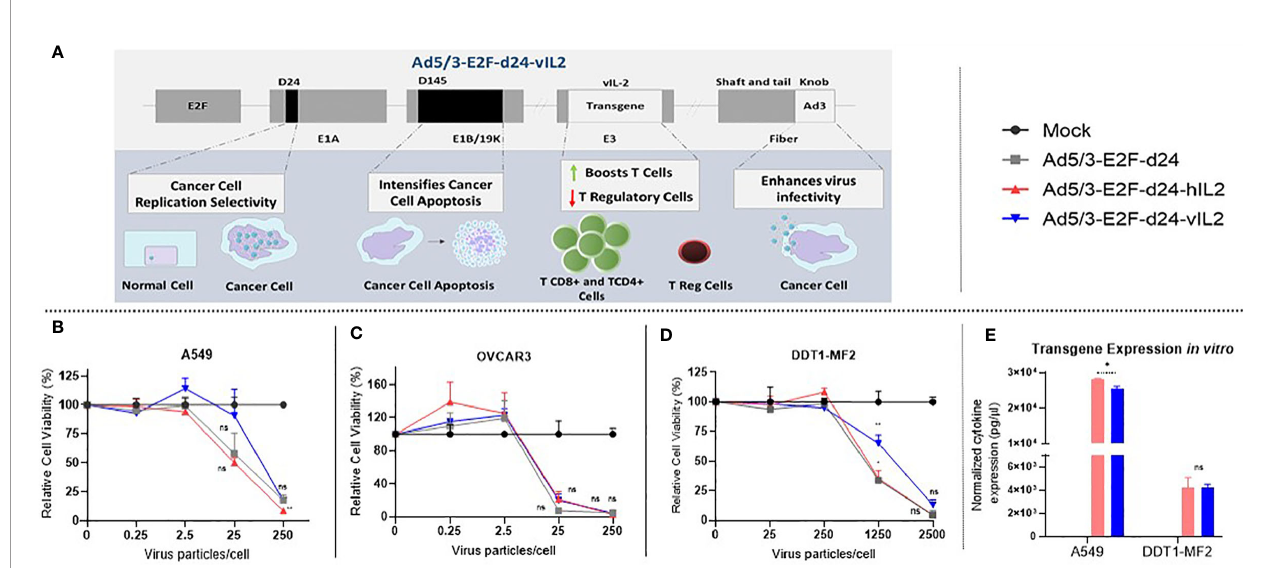
FIGURE 1 | View on the Ad5/3-E2F-d24-vIL2 virus construct and functionality testing in vitro . (A) Graphical illustration of the features of the virus genome. (B – D) Relative cancer cell viability upon Ad5/3-E2F-d24-vIL2 virus infection for 3 (A549) or 5 days (OVCAR3 and DDT1-MF2). (B) Human lung cancer cell line (A549). (C) Human ovarian cancer cell line (OVCAR3). (D) Hamster leiomyosarcoma cancer cell line (DDT1-MF2). (E) Normalized transgene production in supernatants of virus-infected A549 and DDT1-MF2 cancer cells at 250 and 2500 vp, respectively. All data is presented as mean + SEM. *p < 0.05 and **p < 0.01. ns, not statistically signi fi